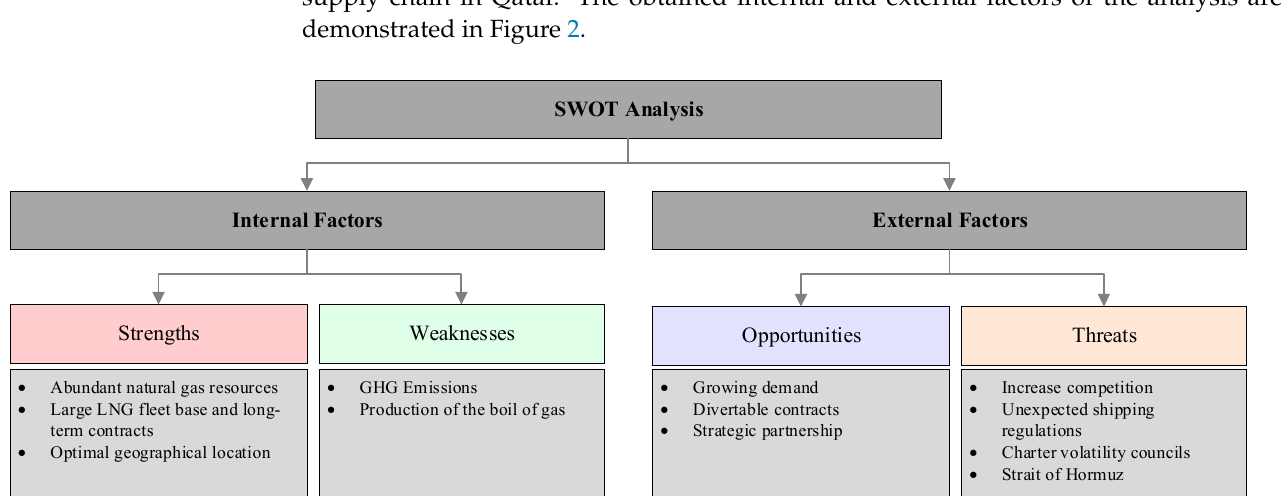
Figure 2. A summary of obtained findings (internal and external factors) from SWOT analysis for the State of Qatar. State of